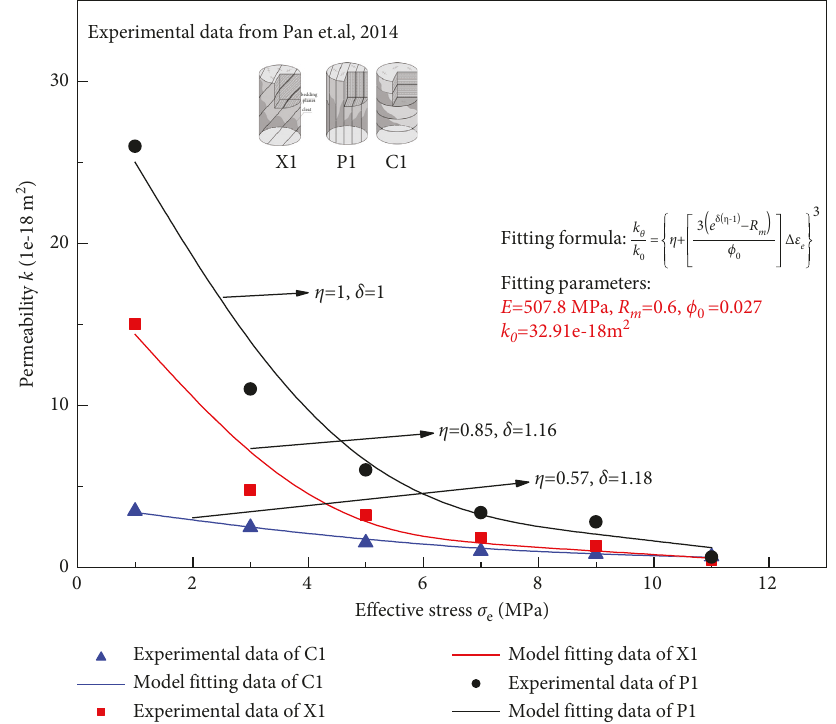
Figure 5: Coal permeability as a function of effective stress. Experimental data are from Pan et al.